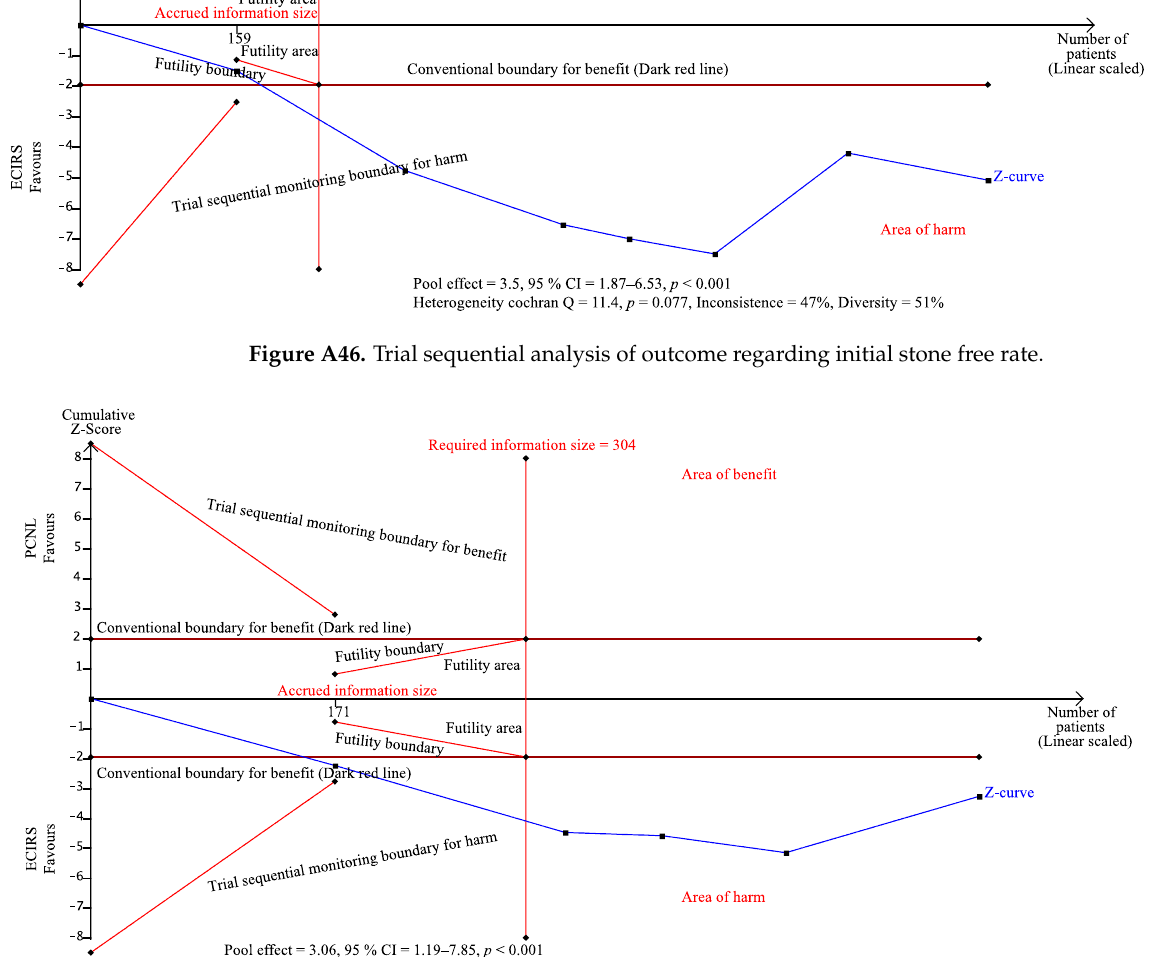
Figure A48. Trial sequential analysis of outcome regarding overall complications.